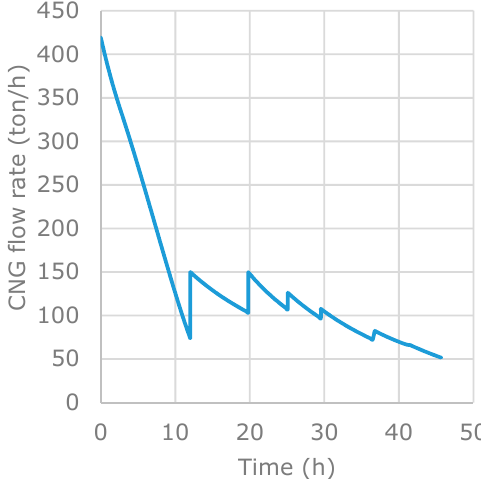
Figure 13. CNG flow rate (adiabatic unloading).